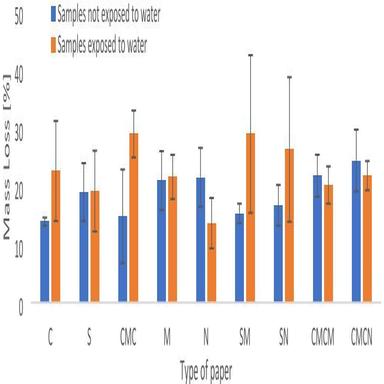
Mass loss of paper treated with biopolymers, silanes, and biopolymers modified with silanes exposed to C. puteana fungus for 40 days.